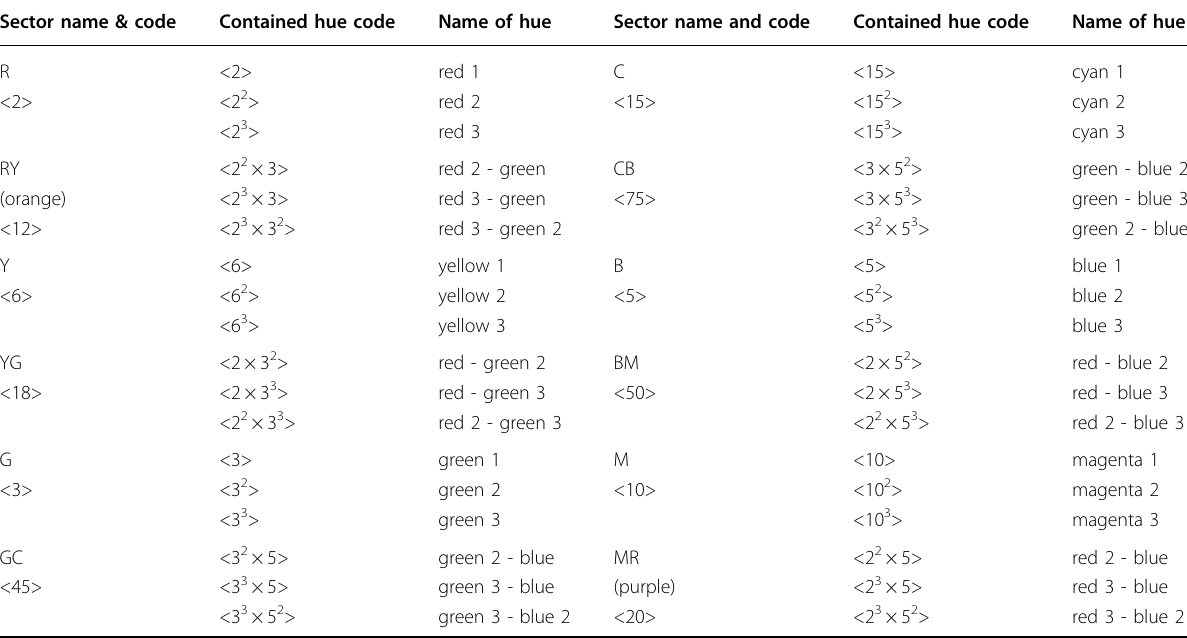
Table 1 A C 235 system with the fi rst 36 hue codes in a table